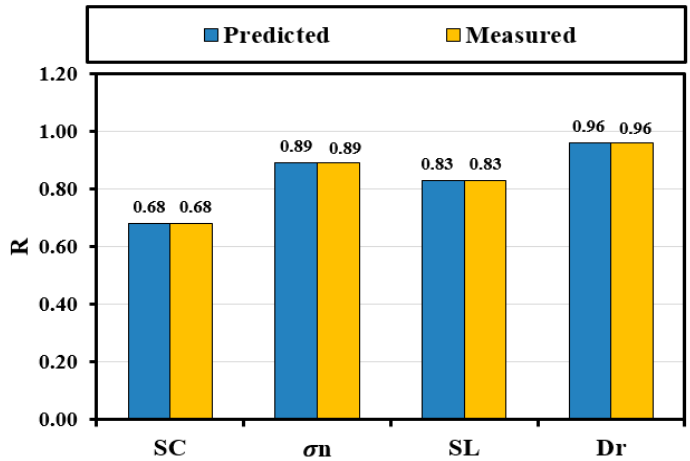
Figure 15. Importance of the variables based on CAM method for coefficient of stress release.